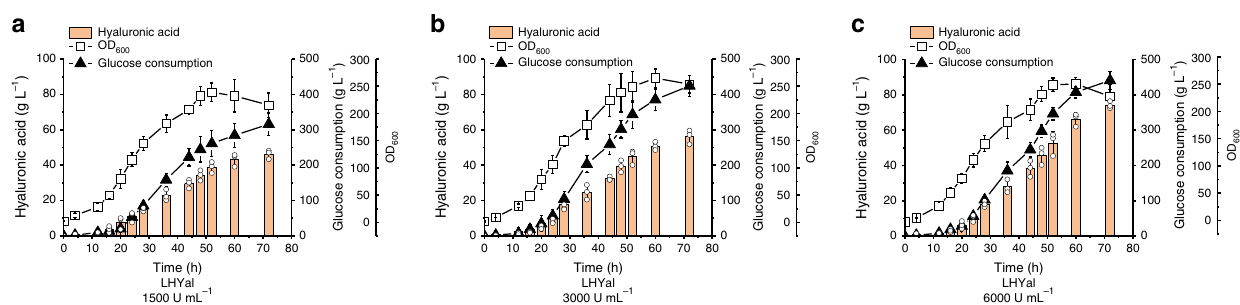
Fig. 6 Fed-batch cultivation of CgspH-7 supplemented with different concentrations of LHYal to increase HA bioproduction. 1500 U mL − 1 ( a ), 3000 U mL − 1 ( b ), and 6000 U mL − 1 ( c ) fi nal concentrations of LHYal were supplemented to the fed-batch cultures of CgspH-7. Total consumed glucose, cell density (OD 600 ) and HA yields were plotted. During cultivation, glucose was fed manually to maintain a concentration at between 10 and 15 g L − 1 , and ammonia [14% (v/v)] was supplemented to maintain pH at between 6.5 and 7.0. All the data are expressed as the mean ± S.D. from three ( n = 3) biologically independent replicates. Each biological replicate of HA concentration assay is presented as the mean value of three technical repeats. Source data are provided as a Source data fi le.